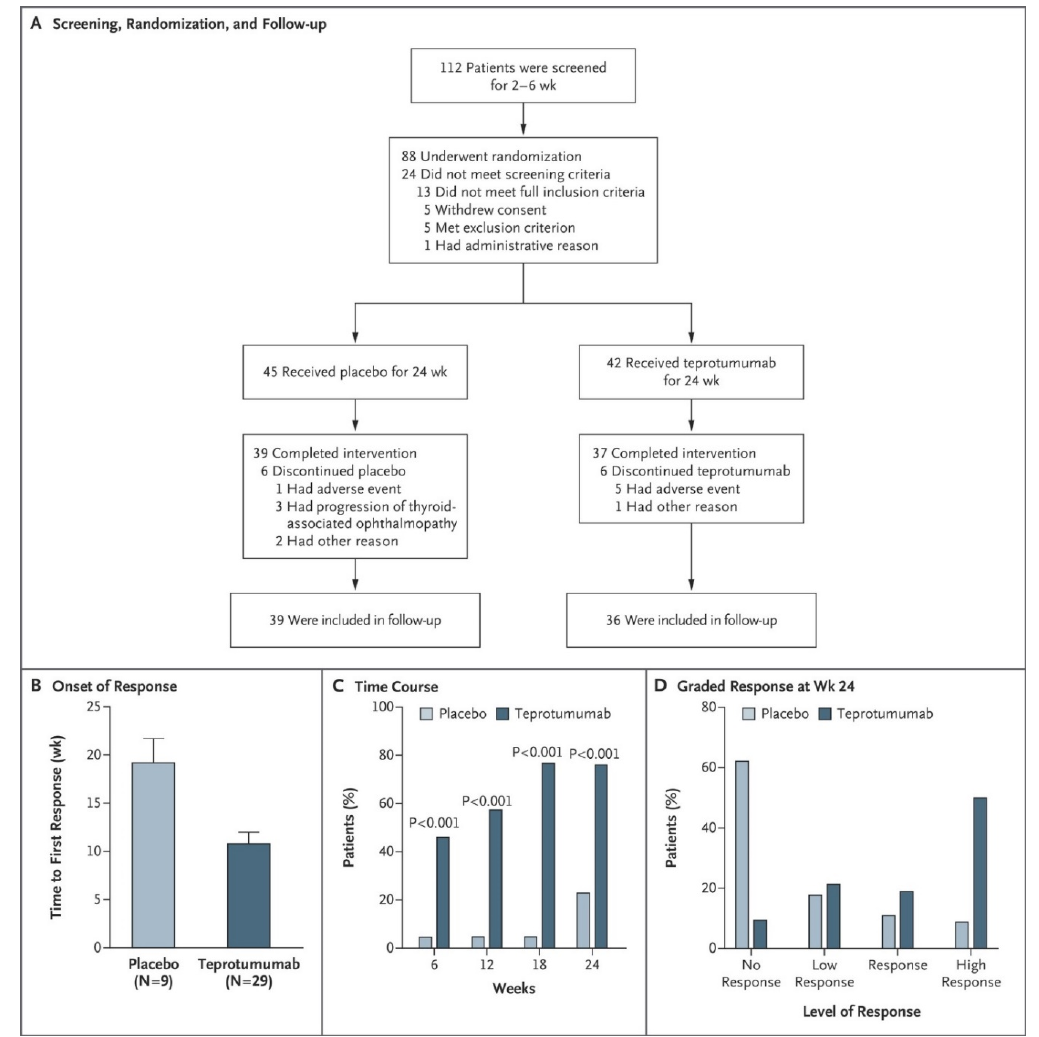
Figure 4. Screening, randomization, response, and follow-up in a phase 2 clinical trial of teprotumumab. ( A ) Patients were screened, and randomized to receive either active drug or placebo for the 24-week treatment phase. They were then followed for 1-year. ( B ) Analysis to first response. ( C ) Time course of patients meeting primary response criteria. ( D ) Responses were graded at week 24. High response indicates ≥ 3 mm proptosis and ≥ 3 point improvement in clinical activity score (CAS) using a seven-point scale. From Smith TJ, Kahaly GJ, Ezra DG, Fleming JC, Dailey RA, Tang RA, Harris GJ, Antonelli A, Salvi M, Goldberg RA, Gigantelli JW, Couch SM, Shriver EM, Hayek BR, Hink EM, Woodward RM, Gabriel K, Magni G, Douglas RS. Teprotumumab for thyroid-associated ophthalmopathy. N Engl J Med. 2017;376(18):1748–1761. Reprinted with permission from ref. [99]. Copyright Massachusetts Medical Society.